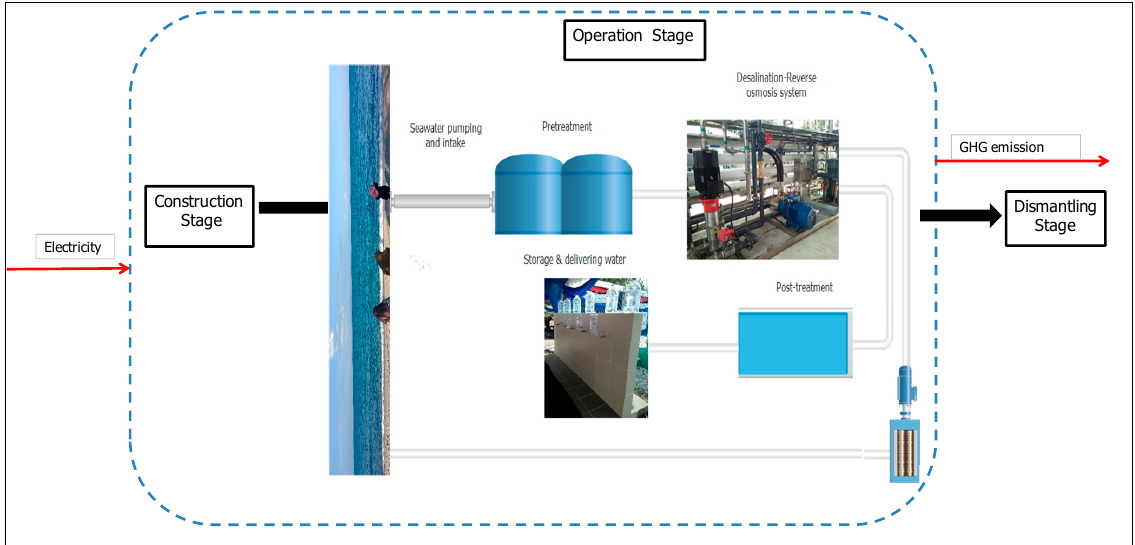
Figure 1. Conceptual images for seawater desalination system boundaries in Senok. The blue dotted point line indicates the boundary of the scope of the study.